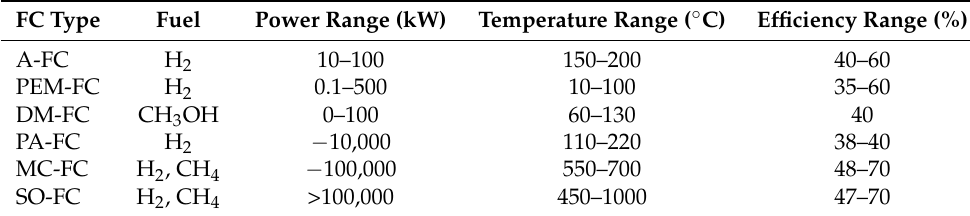
Figure 2. Energy flow diagram of the BEV- and FCEV drive cycle model. Table 3. Types of fuel cells and their characteristics [6,42].